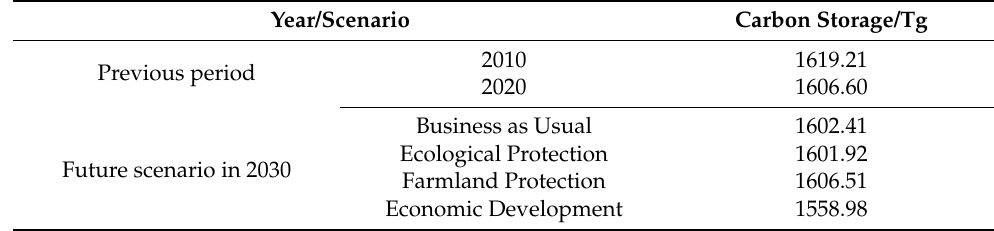
Table 3. Carbon storage amount in 2010, 2020 and 2030 in future scenarios (Business as Usual, Economic Development, Ecological Protection, and Farmland